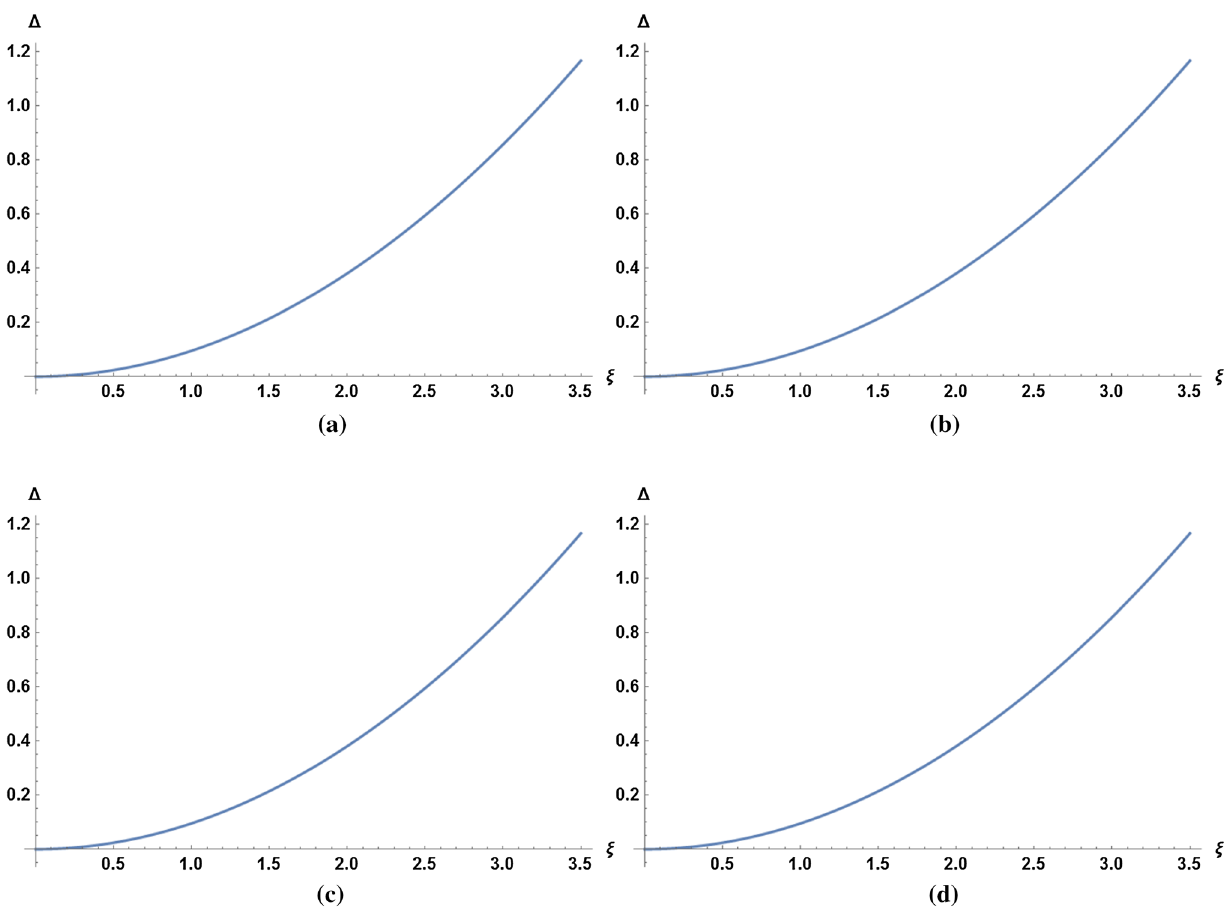
Fig. 6 Graphs between ξ and (cid:12) ; for α 1 = . 5, n = 1 and α = 10 − 10 (curve a ); α = 2 × 10 − 10 (curve b ); α = 4 × 10 − 10 (curve c ) and α = 8 × 10 − 10 (curve d )